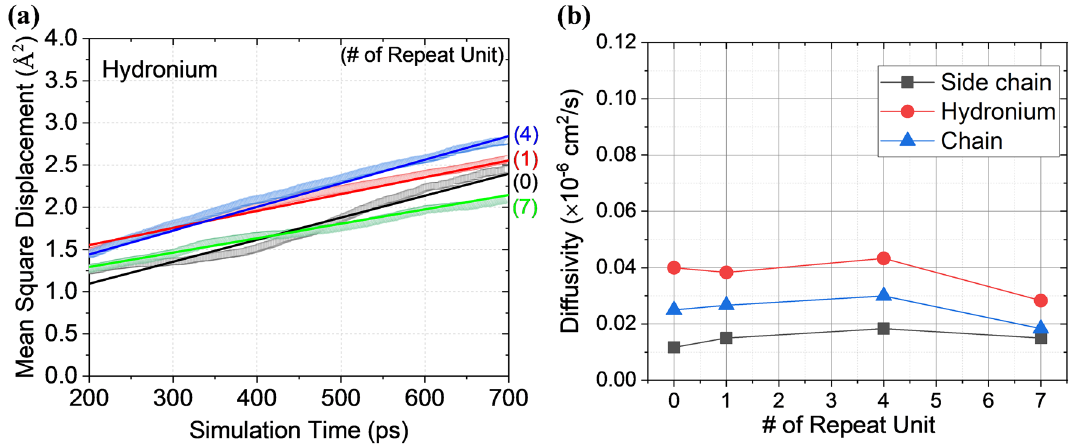
Figure 2. ( a ) Mean square displacement (MSD) of hydronium (H 3 O + ), and derived ( b ) diffusion coefficient of all the